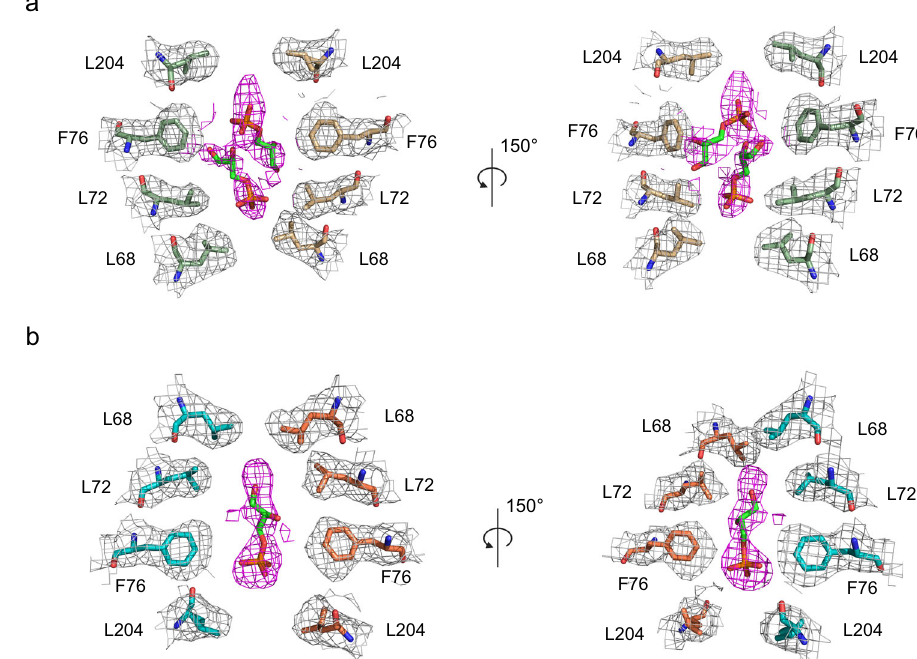
Fig.7|Gro3P fi ttingintothedensityinthecentralpore. Thecentralporeformed by chain A-D ( a ) and E-H ( b ). The Gro3P molecules are shown as green sticks